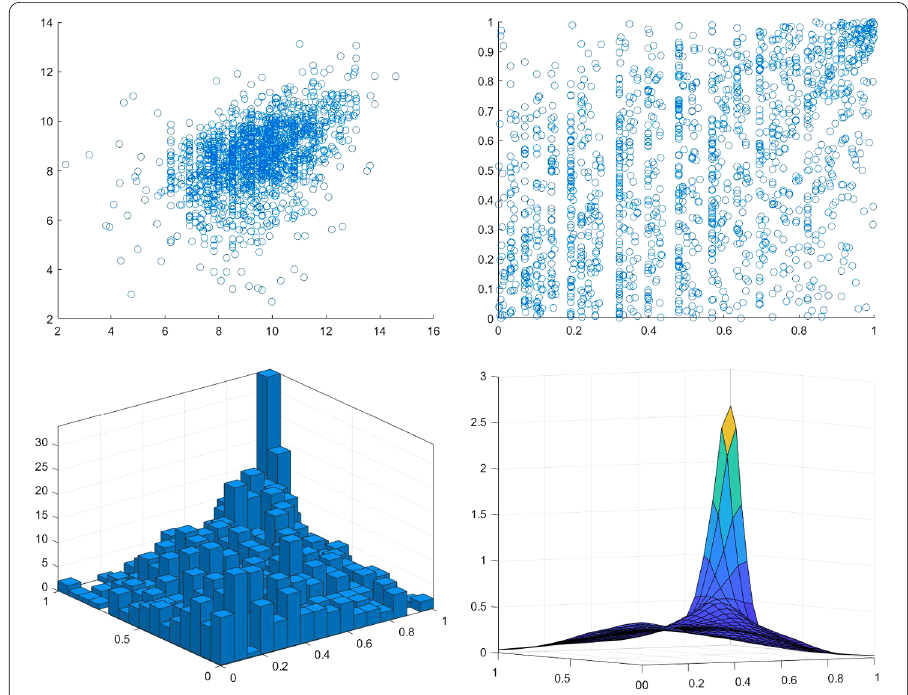
(cid:9) – ˆ α j = 1 0 k 0 k n